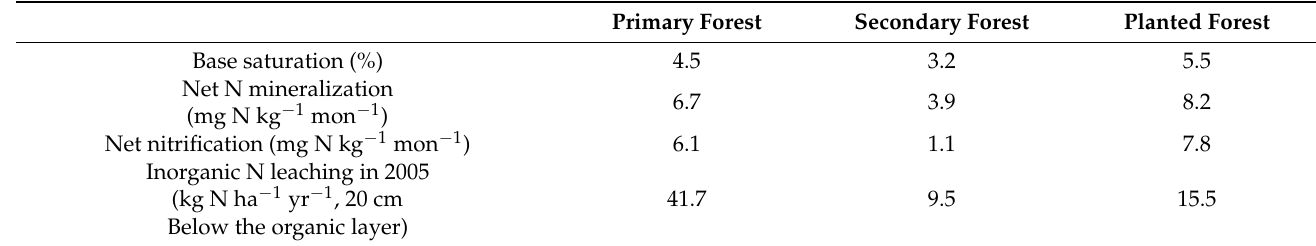
Table 1. Cont. Primary Forest Secondary Forest Planted